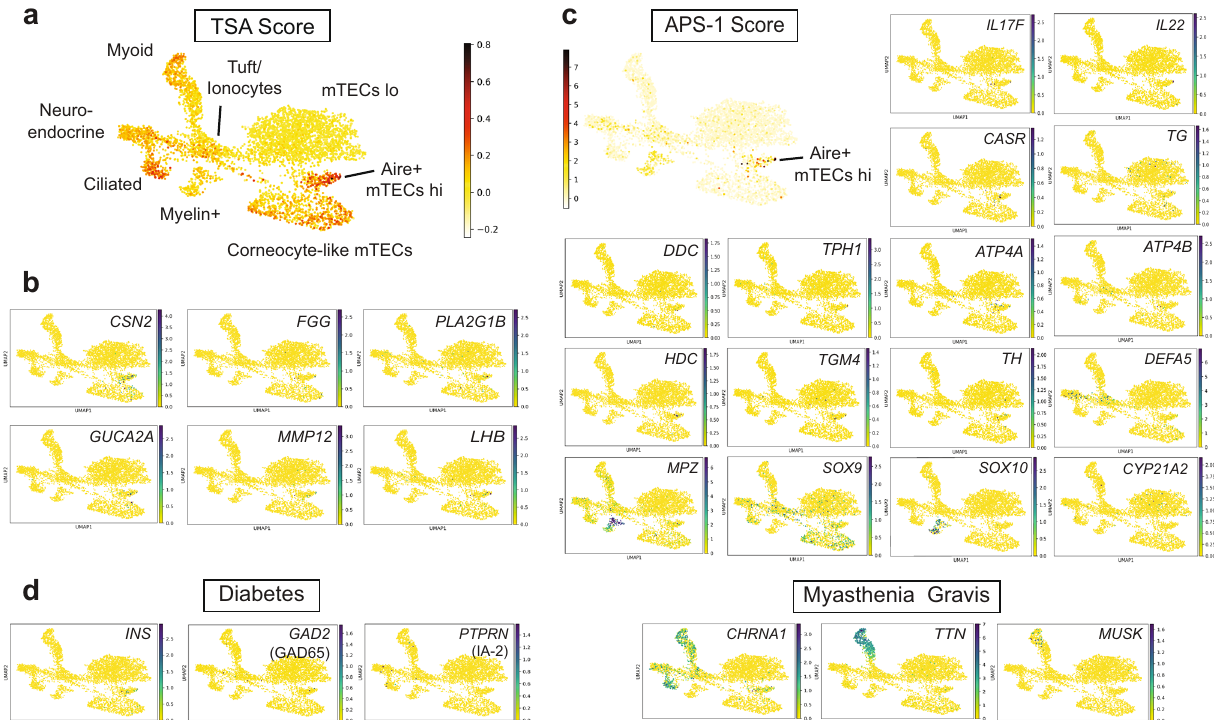
Fig. 7 Characterization of tissue-speci fi c antigen expression by human TECs. a UMAP visualization of the average expression of tissue-speci fi c antigens (TSA score) in medullary epithelial cells. b UMAP visualization of the expression of genes that positively correlate with a high TSA score in AIRE + or corneocyte-like mTECs. c UMAP plots showing the expression of antigens eliciting autoantibodies in APS-1 patients. d Feature plots of antigens eliciting autoantibodies in type 1 diabetes and myasthenia gravis